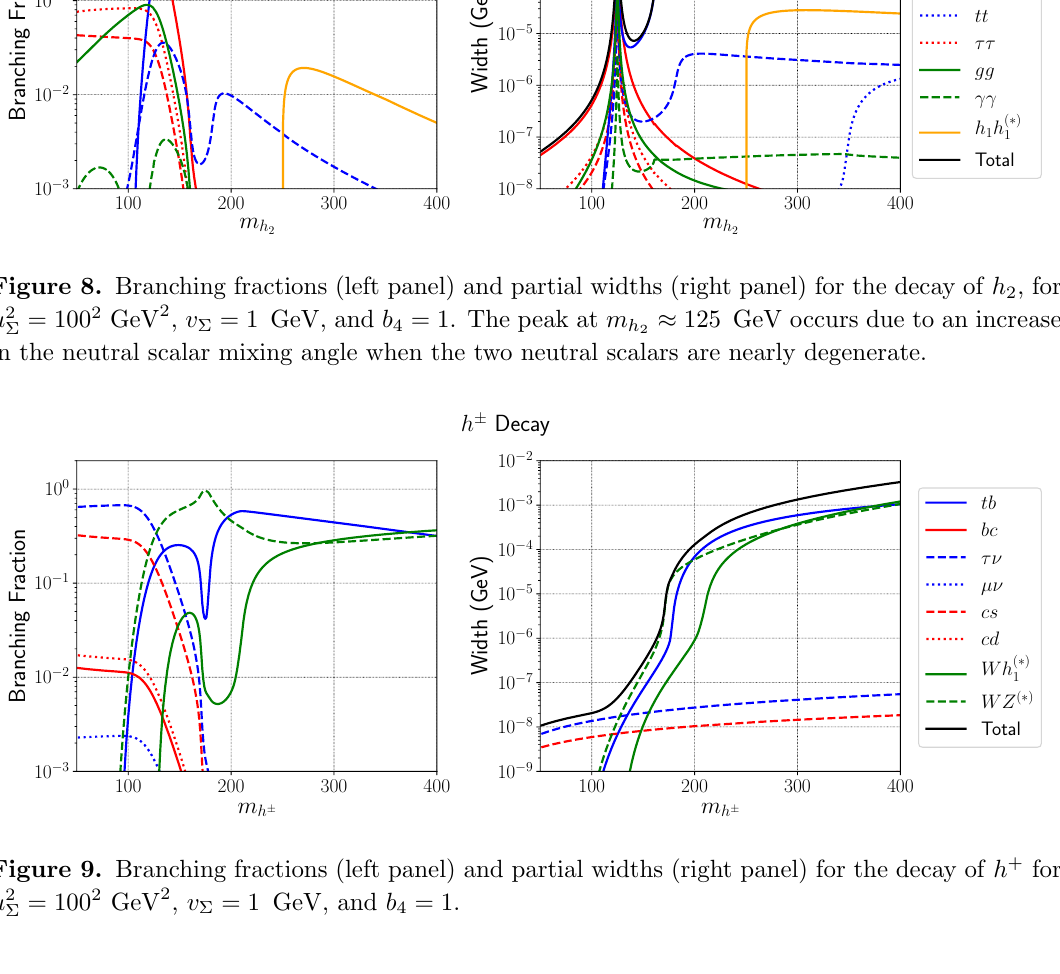
Figure 9. Branching fractions (left panel) and partial widths (right panel) for the decay of h + for (cid:22) 2 = 100 2 GeV 2 , v (cid:6) = 1 GeV, and b 4 = (cid:6)